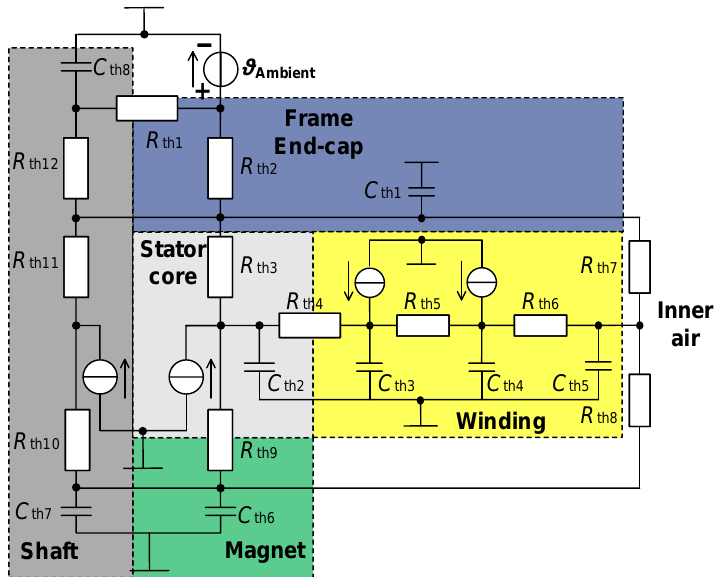
Figure 35. High-order white box thermal model for real-time temperature estimation [47]. Thus, more recently, the synergized thermal models [85], combining lumped-parameter and sub-domain thermal models (SDTM), have been developed for a 12-slot/10-pole fractional slot concentrated winding SPMSM in Figure 36, where the detailed machine parameters can be found in [85]. Afterwards, the SDTMs for the active- and end-windings and PM yield respective governing equations (18), and can be solved by utilizing the finite difference method. The interaction between the LPTM and SDTM, as well as the schematic diagrams of SDTMs, are presented in Figures 36c and 37, respectively. The transient temperature distributions and hotspots for these vulnerable components are estimated numerically based on the information on transient boundary conditions. For instance, when the machine operates under 6.8 Nm at 600 r/min and 4.8 Nm at 7200 r/min with the ambient temperature of 20 ◦ C, the corresponding predicted transient temperature distributions of winding and PM at 20 min are shown in Figure 38. It can be seen that the SDTM has a good prediction capability, especially in terms of critical hotspot temperatures.